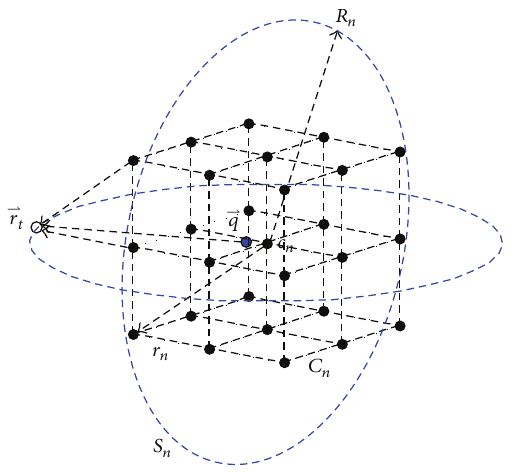
Figure 3: A 3D representation of the matching Green’s